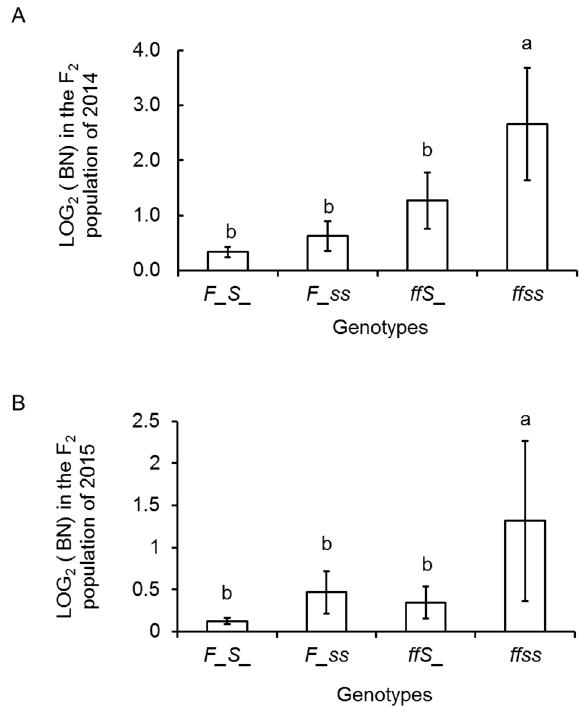
Figure 6. Differences in LOG 2 (BN) values among the four genotypes were compared using Tukey’s HSD test; values are given as mean ± SD. ( A ) LOG 2 (BN) in the F 2 population of 2014; n = 71 ( F_S _), n = 25 ( F_ss ), n = 22 ( ffS _), n = 11 ( ffss ); and ( B ) LOG 2 (BN) in the F 2 population of 2015. n = 57 ( F_S _), n = 19 ( F_ss ), n = 18 ( ffS _), n = 5 ( ffss ). The different letters indicate significance at p < 0.05. S/s represents S allele; F/f represents FA allele.